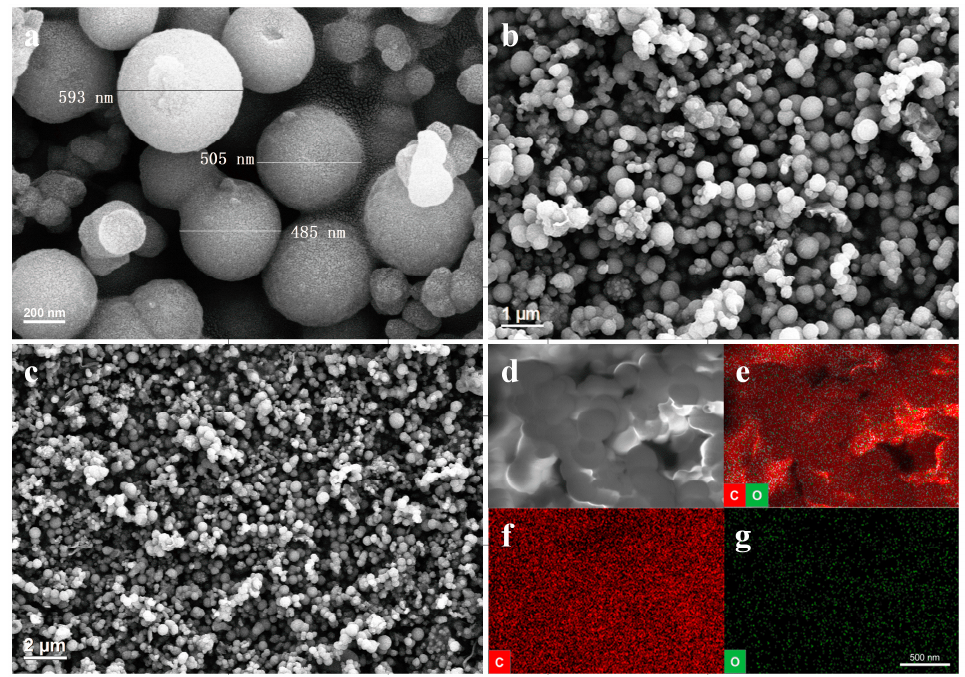
Figure 2. ( a – c ) SEM images of HsGY Powder. ( d – g ) EDS mapping images of C + O ( e ), C ( f ), and O ( g ) of HsGY Powder.